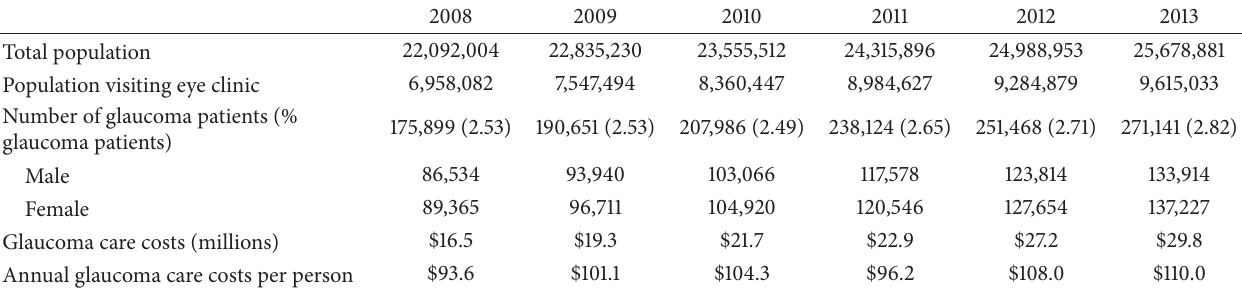
Table 1: Glaucoma prevalence and glaucoma care costs between 2008 and 2013 in Koreans over 40 years of age.